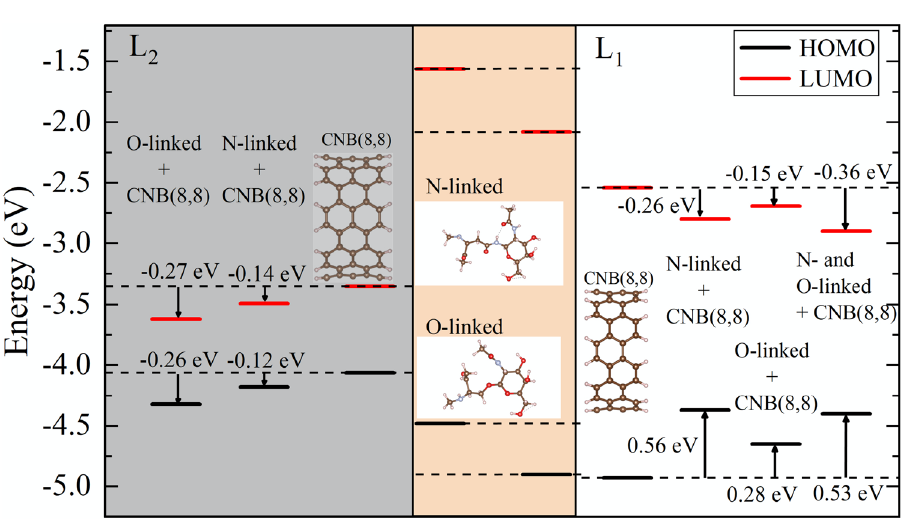
Figure 6. HOMO and LUMO energy levels of glycan molecules and pristine CNB(8,8) with lengths L 1 and L 2 . Renormalized energy levels of CNBs in the presence of glycan molecules are